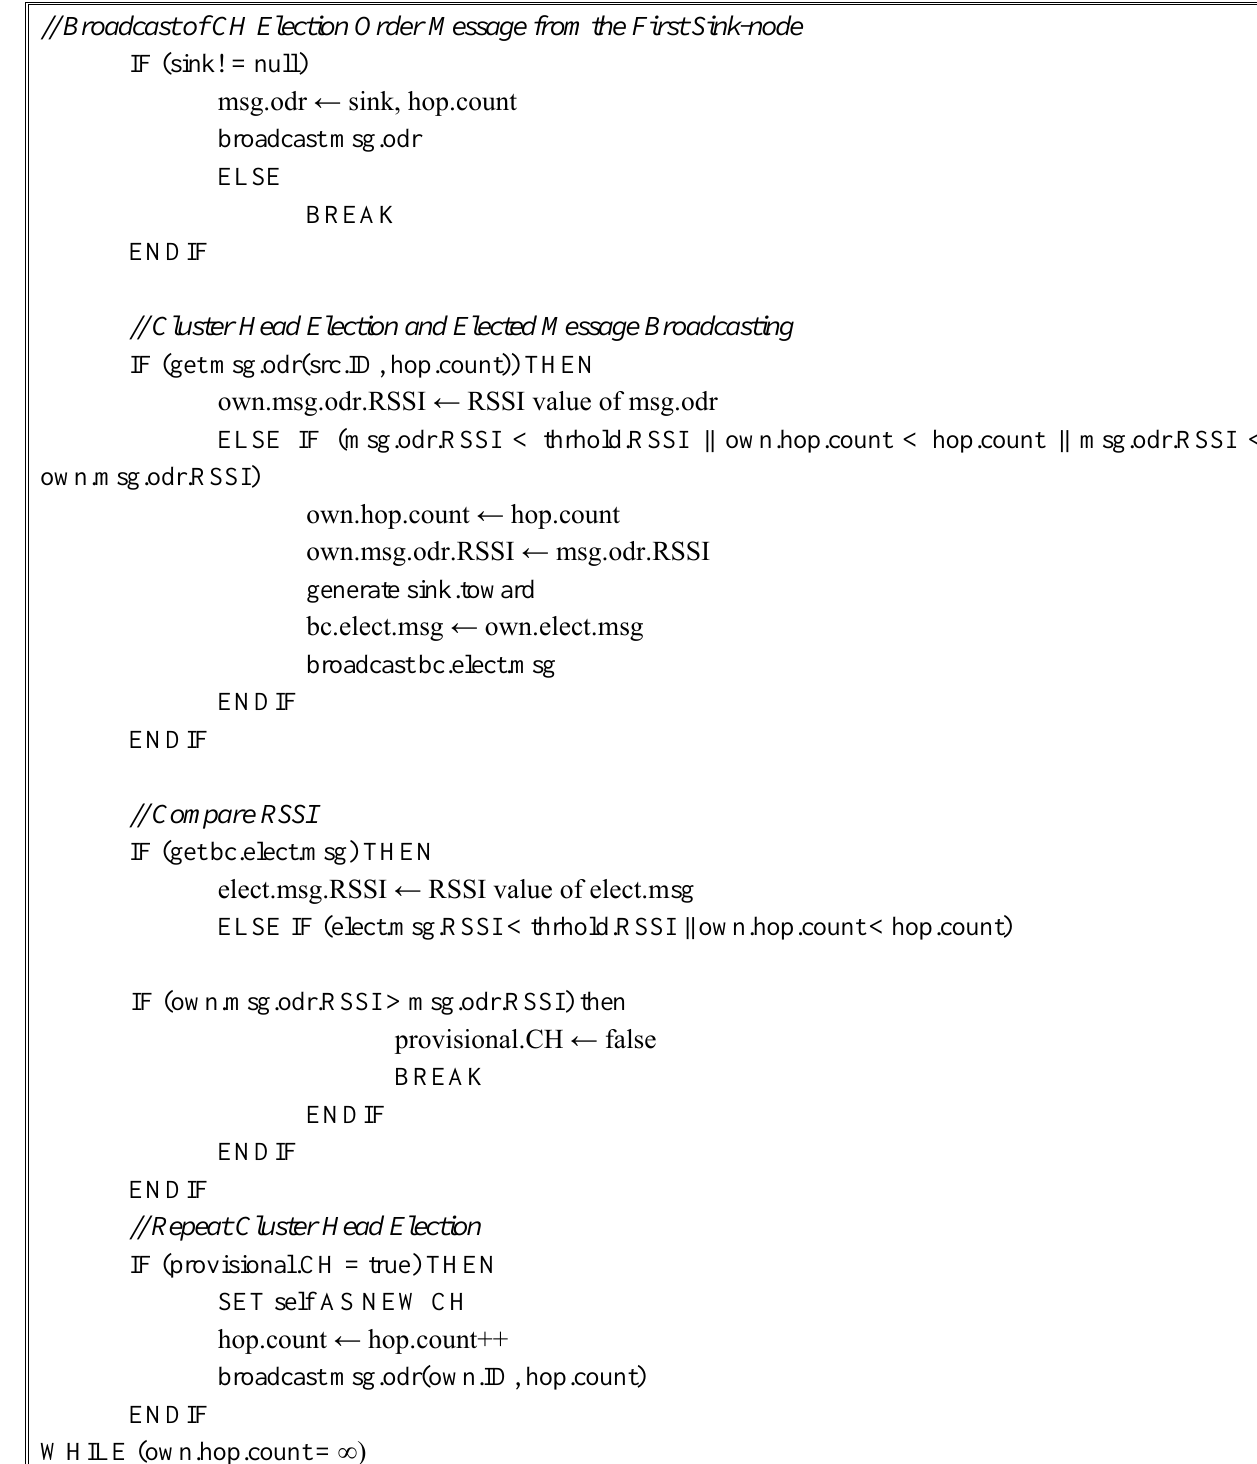
Algorithm 1. Cont